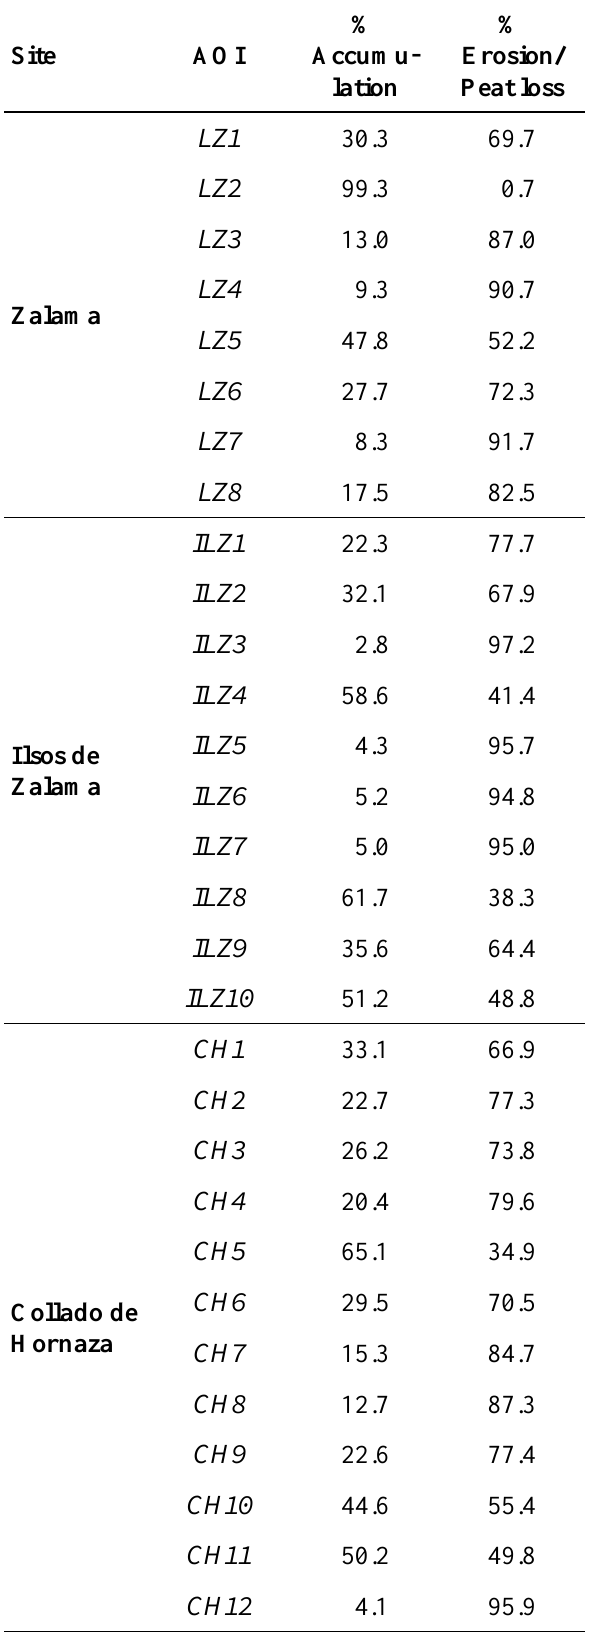
Table 5. Proportion of points in surface differences for each